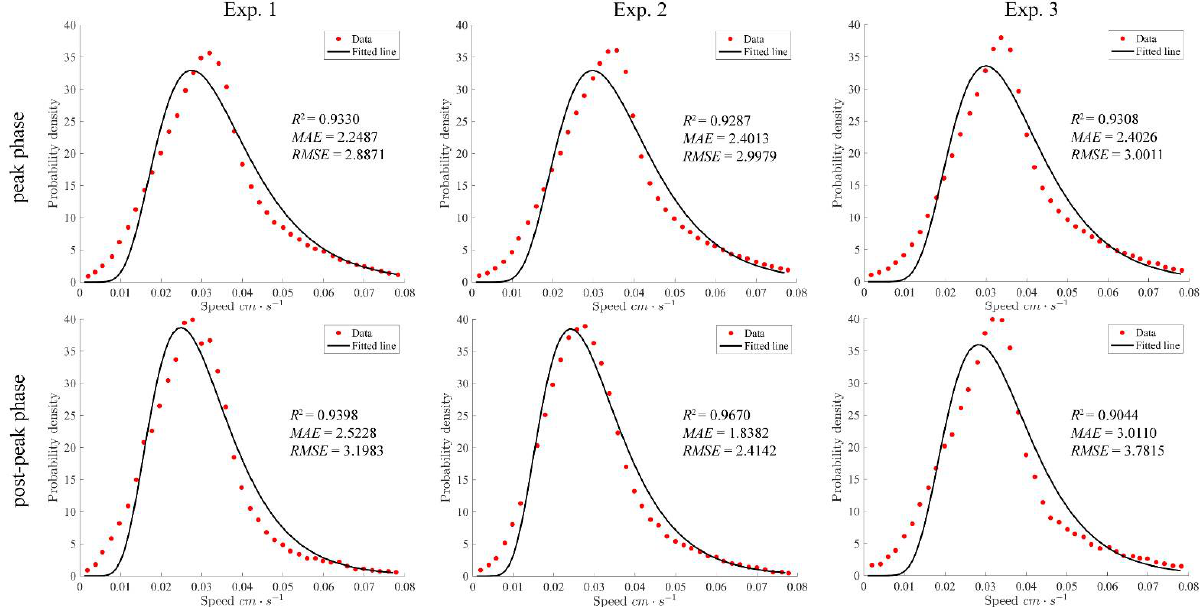
Figure 4. Fat tails in the frequency distributions of swimming speeds of O. marina during the peak ( top ) and post-peak ( bottom ) aggregation phases (Exp. 1 with either direct addition of the prey alga; Exp. 2&3 with cell-free filtrate). The red dots: original data; black line: fitted curve using Log-normal distribution formula.